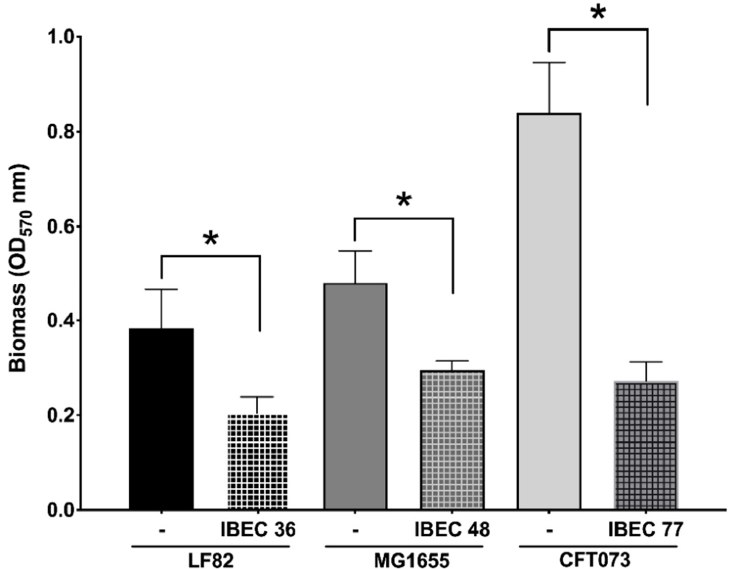
Figure 4. Effect of relative in vitro biofilm reduction in E. coli CFT073, E. coli LF82, and E. coli MG1655 by IBEC77, IBEC36, and IBEC48 phages, respectively, with phage concentration of 1 × 10 6 pfu/mL after 3-day-old biofilm (72 h) growth in 96-well plates at 37 °C. Standard deviations are indicated. (*) Statistically significant differences representing (* p < 0.0001) were determined by unpaired t -test (GraphPad Prism v.9).